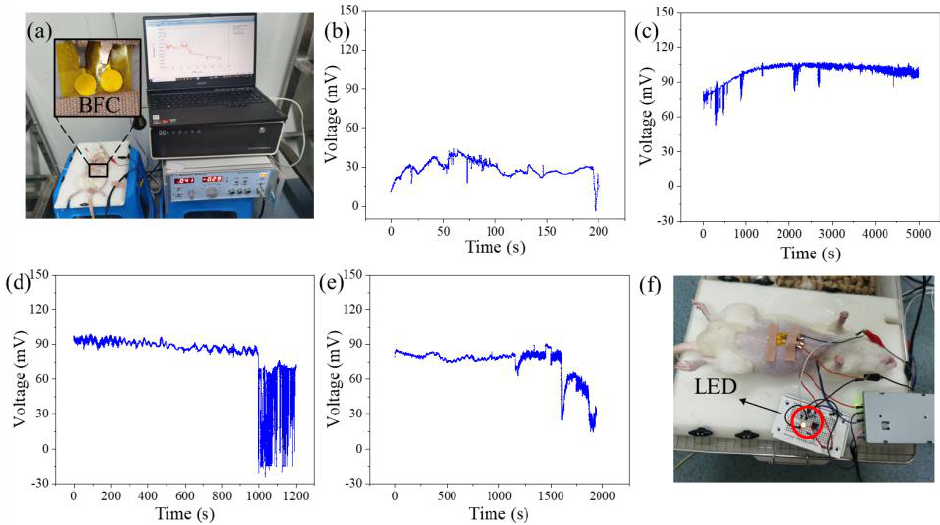
Figure 4. ( a ) Photo of the animal experiment. ( b ) Voltage output before electrical activation. ( c ) Volt- age output after electrical activation of 150 mV. ( d ) Voltage output after first 40 mV electrical activation. ( e ) Voltage output after second 40 mV electrical activation. ( f ) Photo of an LED, lit up based on the BFC.